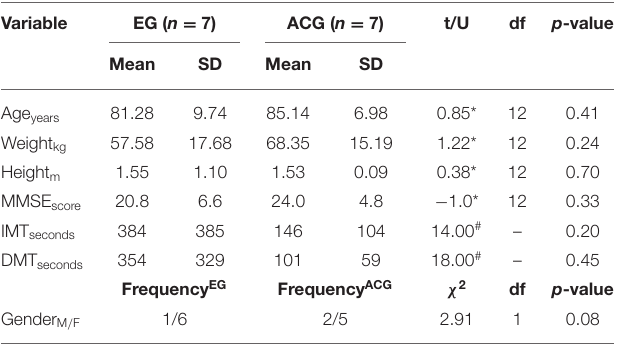
TABLE 1 | Demographic, global cognition, and spatial navigation